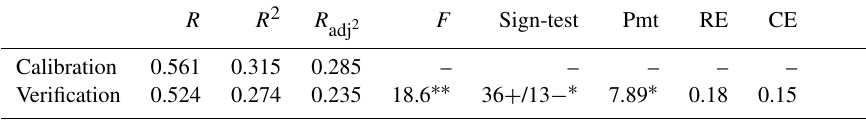
Table 2. Leave-one-out verification statistics for the NGS precipitation reconstruction.